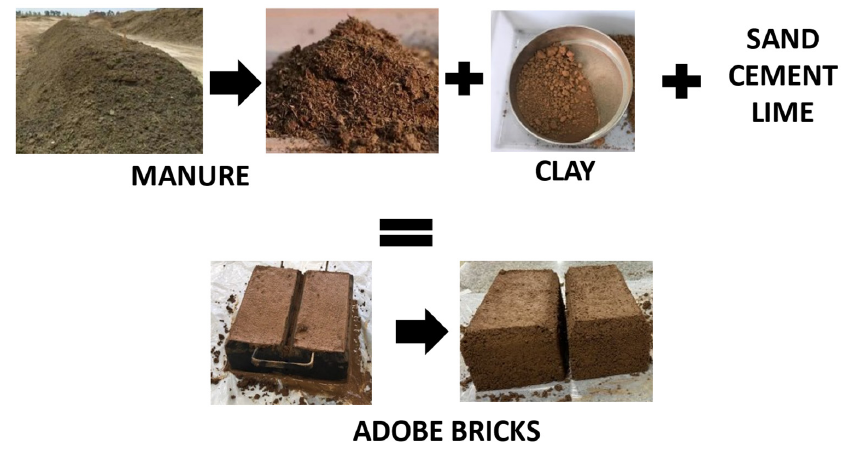
Figure 3. Flowchart of production of adobe blocks with clay and manure.